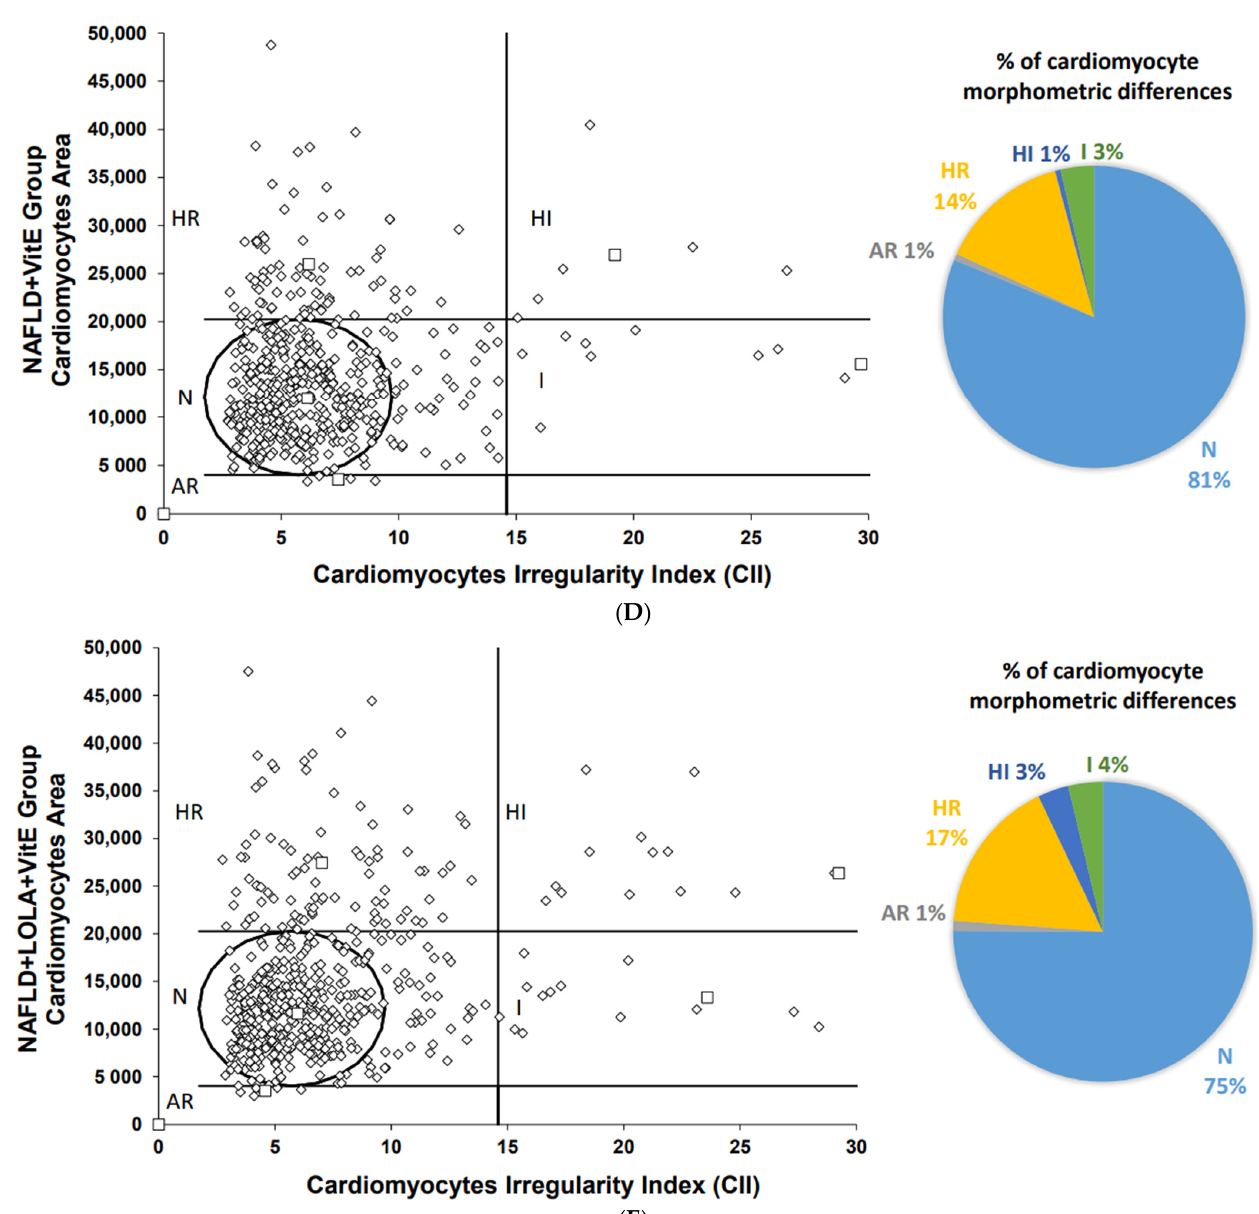
Figure 4. Cardiomyocytes morphometric analysis. The area and cross-sectional shape of cardiomyocytes were determined from images of hematoxylin and eosin-stained tissue. Dot plot of cardiomyocytes area vs. cardiomyocytes irregularity index in ( A ) Control; ( B ) NAFLD; ( C ) NAFLD+LOLA; ( D ) NAFLD+VitE, and ( E ) NAFLD+LOLA+VitE. Each dot represents a population of cardiomyocytes with different morphometry. Data expressed in percentage (%). AR: atrophic regular; HI: hypertrophic irregular; HR: hypertrophic regular; N: normal area and shape, I: irregular area and shape.